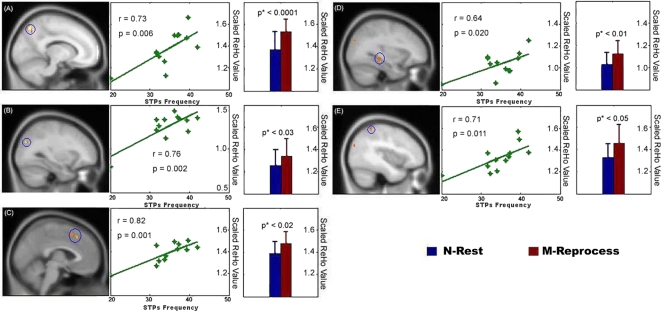
The STPs-network Regions.The ReHo-reflected activity in those regions were significantly correlated with subjects' STPs frequency scales (total score = 60) during the N-Rest, and were significantly stronger during the M-Reprocess than during the N-Rest. (A) PCu (BA 7; (−12, −69, 51); cluster = 729 mm3). (B) AG/SOG (BA 39/19; (−30, −78, 30); (−42, −81, 24); cluster = 270 mm3). (C) mPFG (BA 8/6; (−3, 24, 45); (−3, 15, 51); cluster = 297 mm3). (D) HIP/PHIP ((−31, −38, −13); (−33, −33, −3); cluster = 324 mm3). (E) IPL (BA 40; (−39, −48, 57); cluster = 243 mm3). All coordinates were in the Montreal Neurological Institute (MNI) space. The p* value is a corrected significance determined by Monte Carlo simulation.